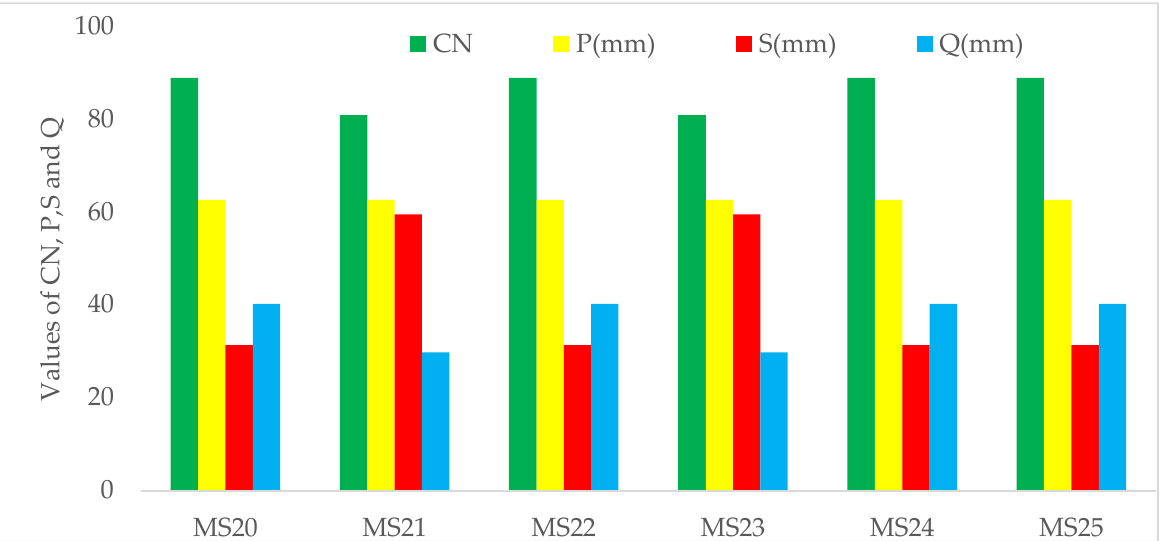
Figure 9. The runoff depth (mm) for the stormwater samples collected over six monitoring stations in Hawassa City.